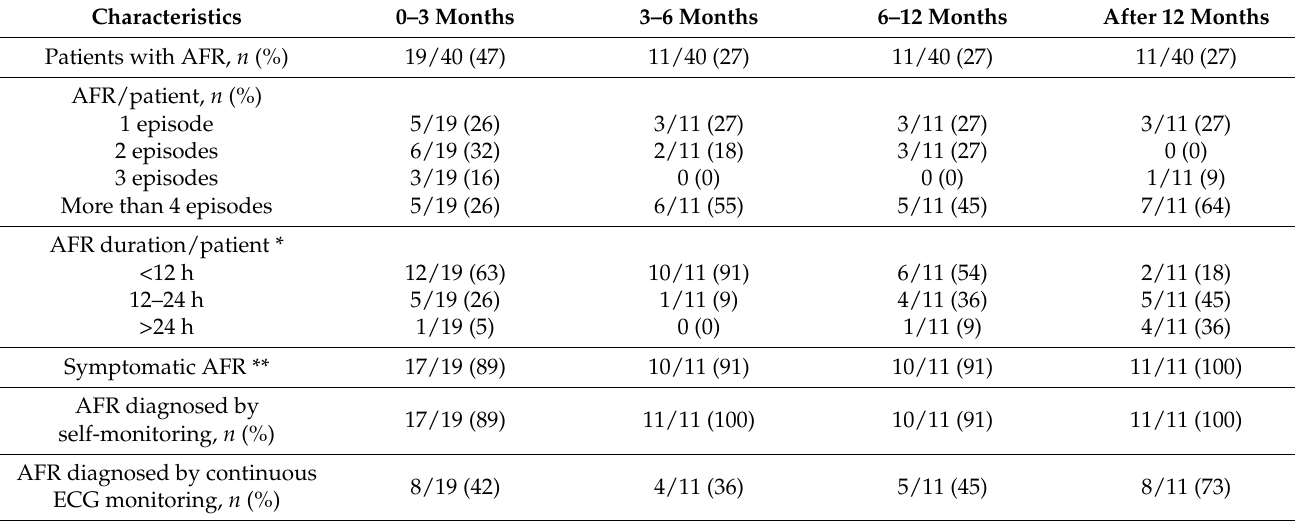
Table 2. Atrial fibrillation assessment at different intervals of time.